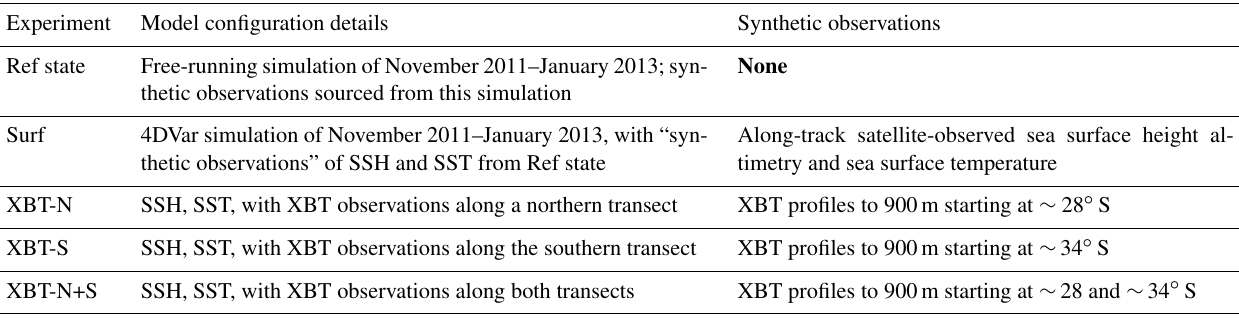
Table 1. The experimental configurations of the Ref state and OSSEs are shown, with details of the synthetic observations. Bold indicates that the item is not applicable for the Ref